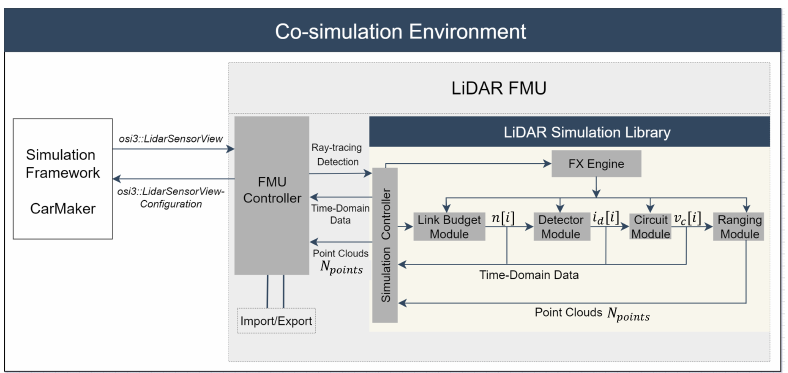
Figure 4. Co-simulation framework of the LiDAR FMU model